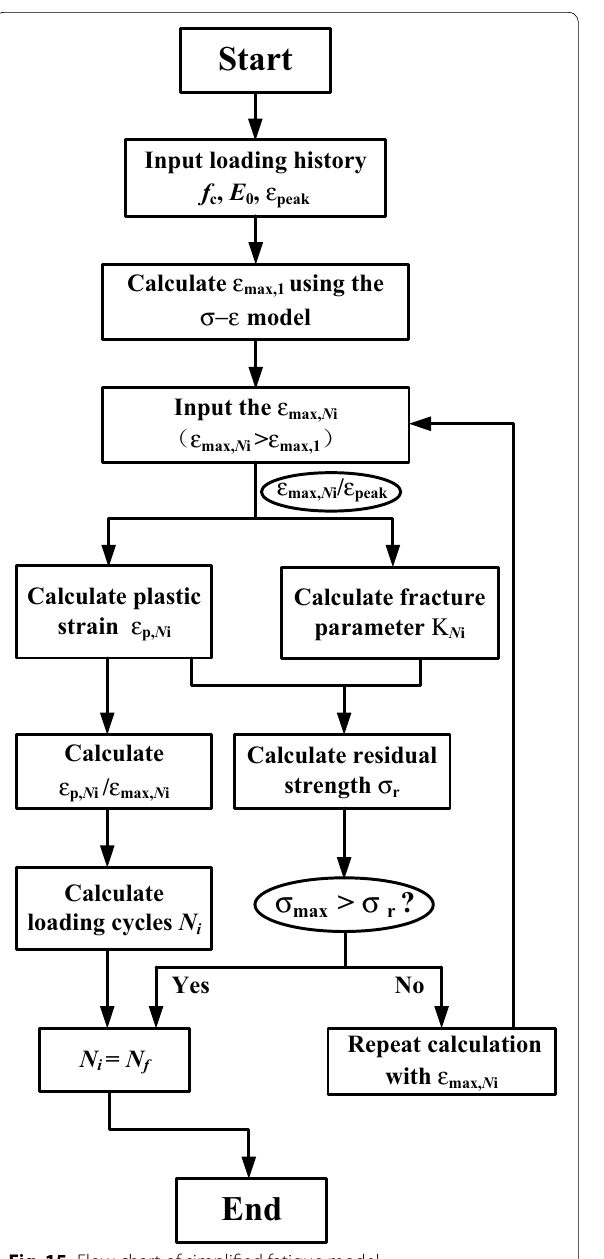
Fig. 15 Flow chart of simplified fatigue model.